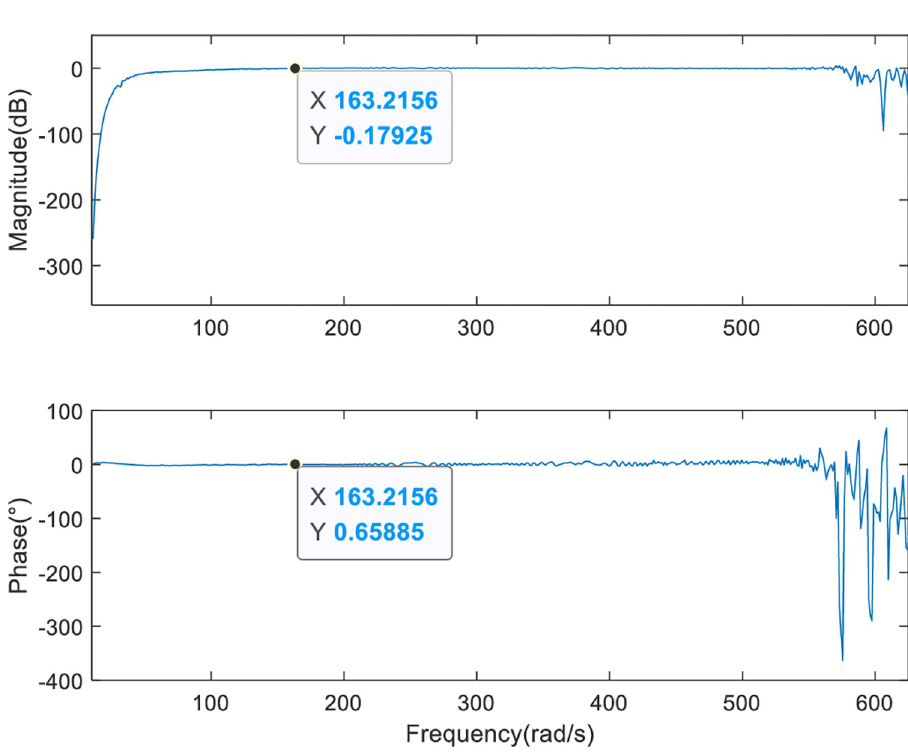
Fig 15. Identification